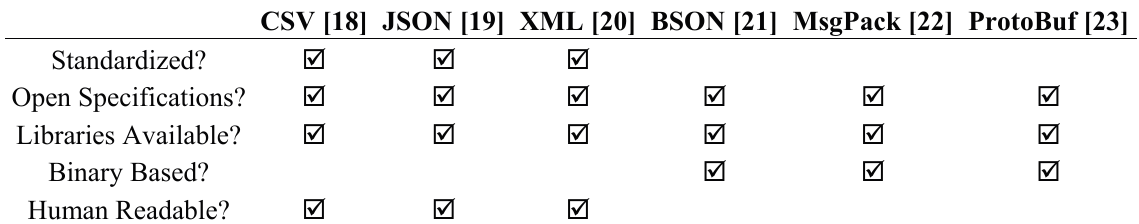
Table 3. Key enabling M2M data serialization formats for future mHealth